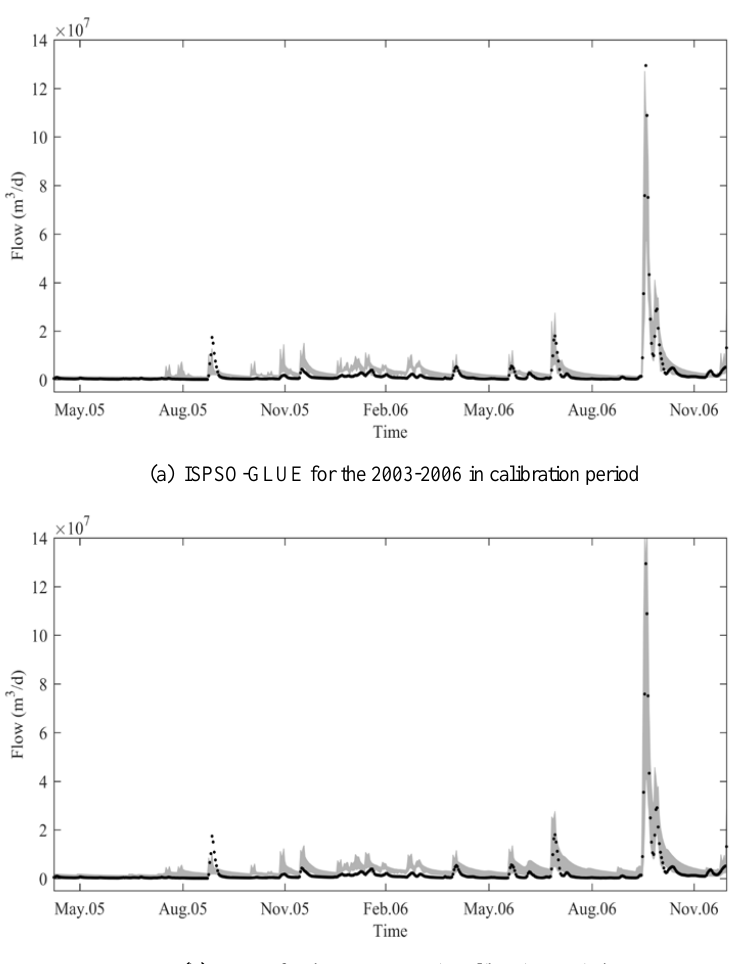
Figure 3. The 95% uncertainty bounds for the 2003–2006 calibration period from May 2005 to November 2006 (wettest period with the highest peak flow). The shaded area and dotted line represent the uncertainty bounds and observed flows, respectively.